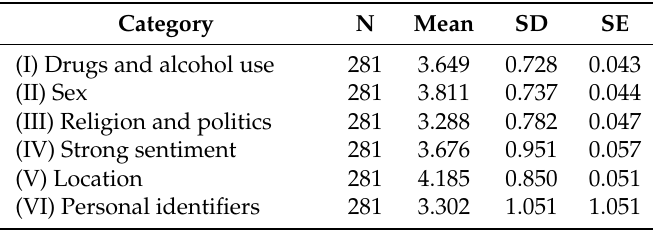
Table A2. Descriptive statistics of each information category.